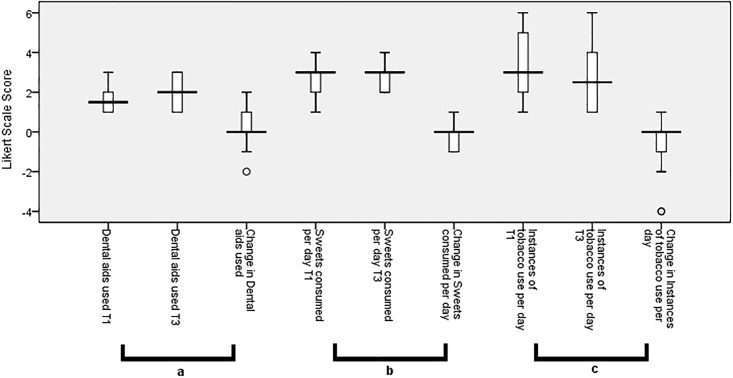
Significant change in self-reported behaviour between Pre-Test (T1) to Follow-Up (T3).a) Use of dental cleaning aids (tooth brush, interdental aids) reported at T1 and T3. Increase in the Likert score indicates increase in the use of dental cleaning aids. Significant increase in the use of dental cleaning aids was identified, b) Number of sweets consumed per day reported at T1 and T3. Decrease in the Likert score indicates a reduction in the number of times sweets were consumed per day. Significant decrease in the number of sweets consumed per day was identified. c) Instances of tobacco use reported at T1 and T3. Decrease in the Likert score indicates decrease in the number of instances of tobacco use per day. Significant decrease in the number of instances of tobacco use per day was identified.